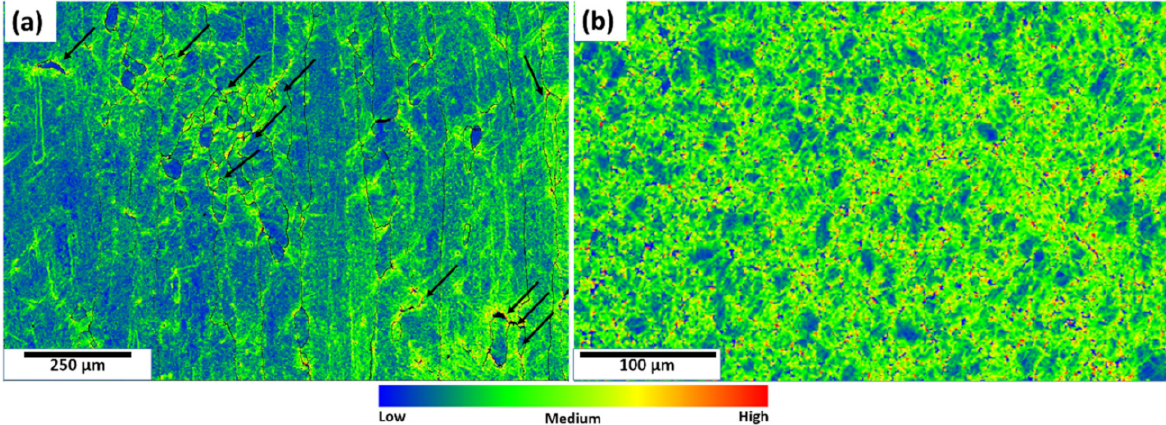
Figure 14. Local misorientation maps after creep test for ( a ) the EBM IN718 specimen and ( b ) the C&W IN718 specimen. The black arrows indicate fine